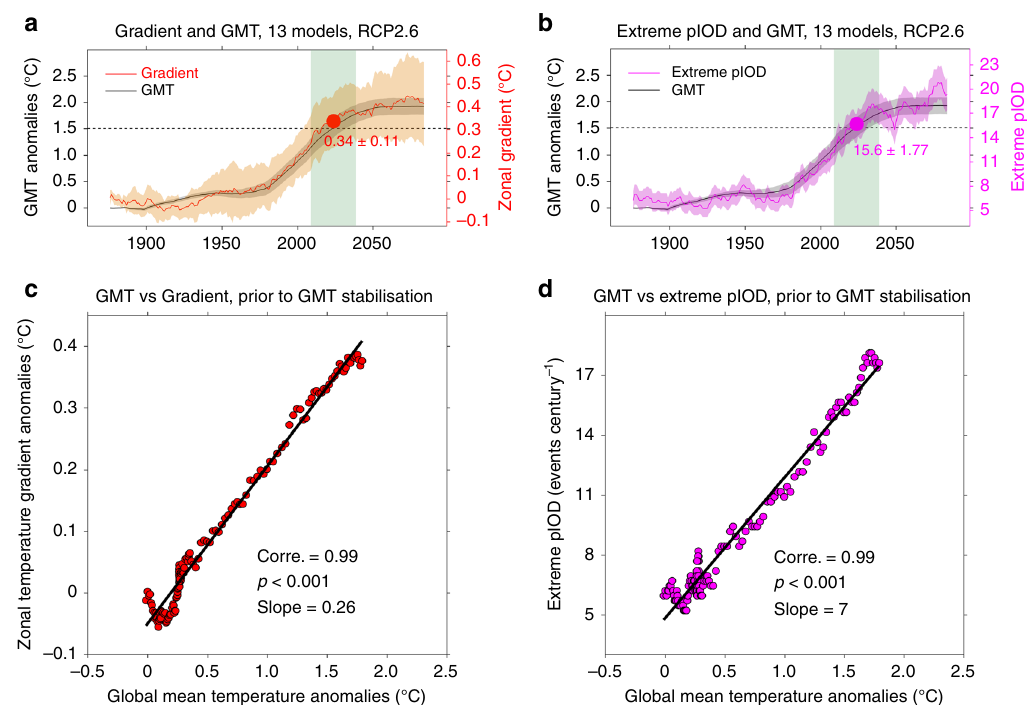
Fig. 3 Temporal evolution of multi-model ensemble mean changes under the RCP2.6 scenario. a GMT anomalies (black curve) and zonal temperature gradient anomalies at the equatorial Indian Ocean (red curve) referenced to the pre-industrial condition (1869 – 1899) and averaged over 31-year sliding windows from 1869 to 2099 period. Their 90% con fi dence intervals are indicated by grey and light orange shades, respectively, based on a Student ’ s t - distribution. The value near the red circle indicates the average over the 31 years centred at 1.5 °C warming (light green-shaded zone). b The same as a , but for the extreme pIOD frequency (purple curve, events per century). The 90% con fi dence intervals (light purple shades) are estimated based on Poisson distribution (see Methods section). The value near the purple circle indicates the average over the 31 years centred at 1.5 °C warming (light green-shaded zone). Results are based on 13 available models. c Relationship between the GMT anomalies and the multi-model mean zonal temperature gradient anomalies during the period of transient increase in CO 2 . The correlation coef fi cient, P -value and slope are all indicated. d The same as c , but for